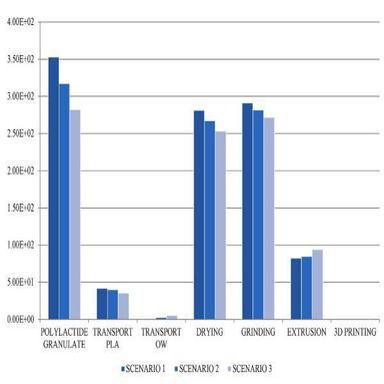
Process contribution to ADP-fossil impact (MJ) for each FFF printing process stage.